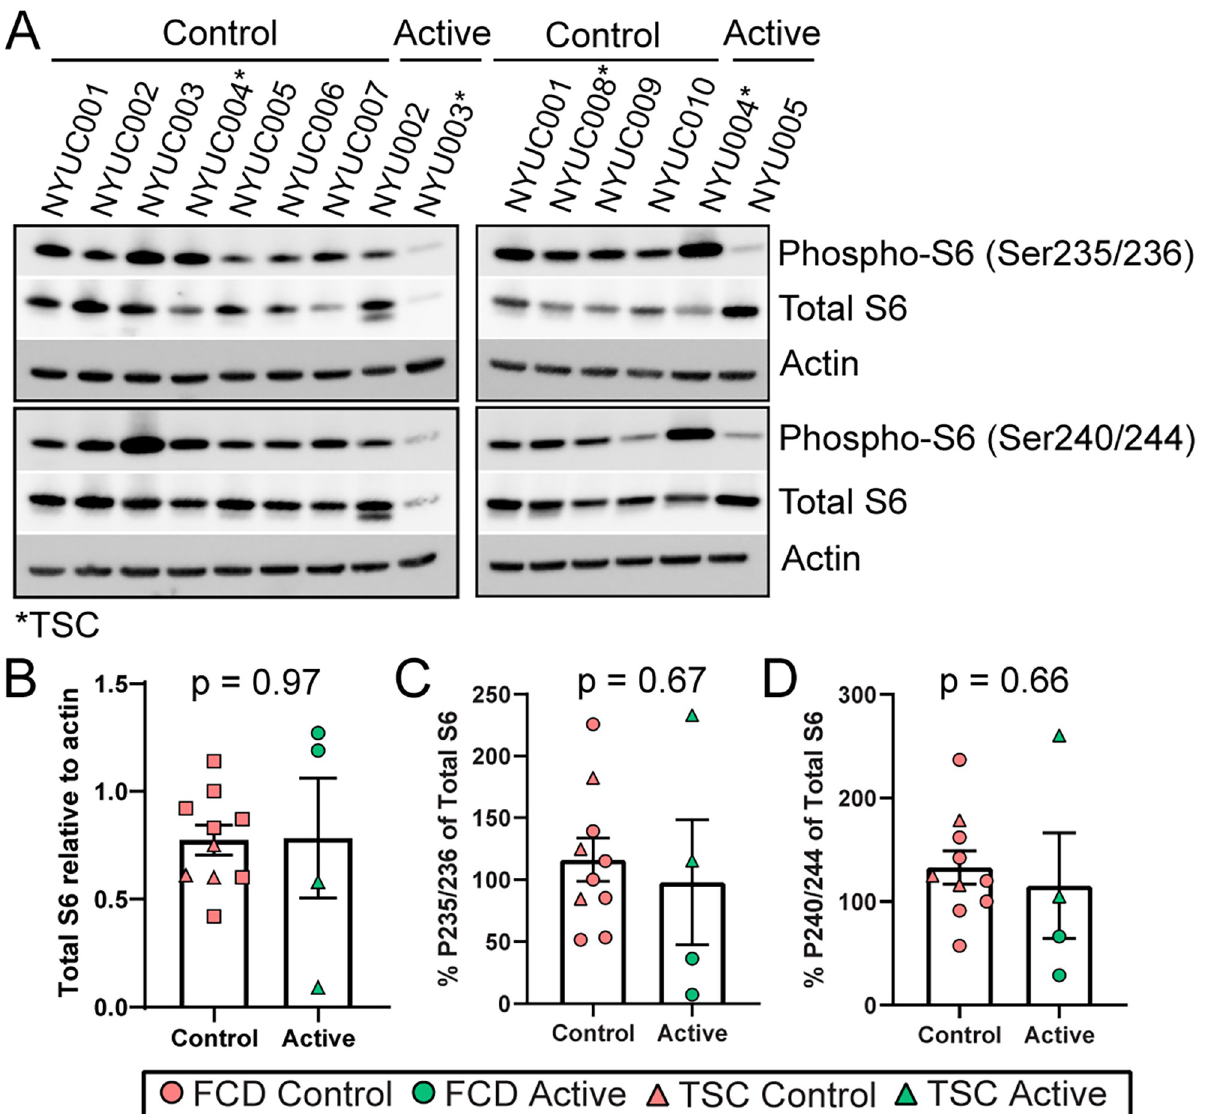
Fig 1. Ribosomal S6 phosphorylation in whole brain homogenate. A) Representative western blot images from surgically resected brain tissue of Active participants after taking 4.5 mg/m 2 everolimus for 7 days and controls. Total S6, phospho-S6 (Ser235/236), phospho-S6 (Ser240/244), and beta- actin as loading control were evaluated in 14 participants. TSC participants are indicated “ � ”, while all others are FCD participants. B) Quantification of total S6 relative to actin indicates variability in baseline levels from sampled brain tissue, as well as one patient with increased expression of a smaller detected band (NYU-002). C) Percentage of phospho-S6 (Ser235/236) relative to total S6 indicates an average 1.19-fold decrease when comparing all Active participants to controls (p = 0.67). The highest level was seen in NYU-004. D) Percentage of phospho-S6 (Ser240/244) relative to total S6 indicates an average 1.15-fold decrease when comparing all Active participants to controls (p = 0.66). The highest level was seen in NYU-004. Error bars indicate